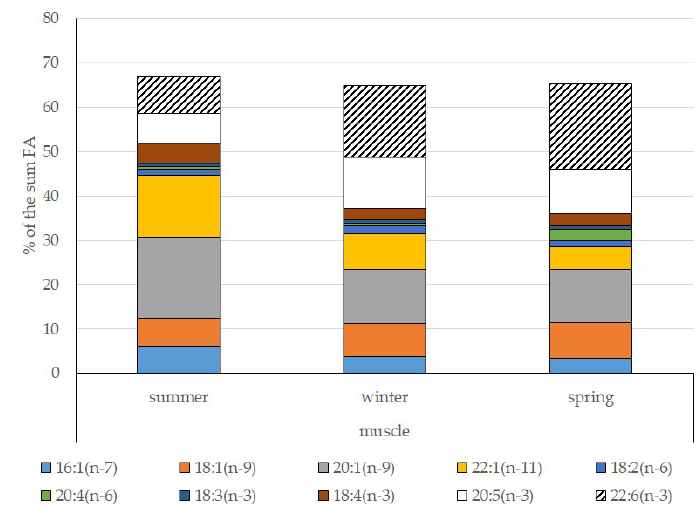
Figure 7. Seasonal dynamic of certain MUFA and PUFA levels (% of the sum of FAs) in muscle in postlarval (L3 developmental stage) daubed shanny from Kongsfjord.